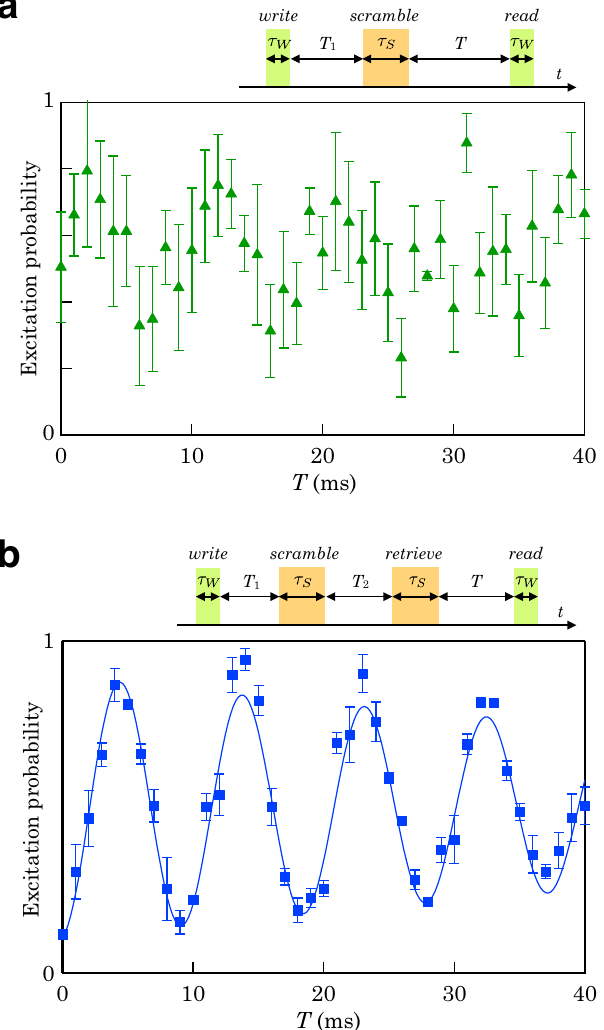
Figure 3. Experimentally obtained scrambled and retrieved Ramsey flops. ( a ) Encrypted state: excitation probability after the application of a scramble pulse in between the write and read pulses. The large error bars indicate the fluctuation of the excitation probability caused by the random phase modulation of the scramble pulse. ( b ) Decrypted state: excitation probability after the application of scramble and retrieve pulses in between the write and read pulses. After the application of a retrieve pulse, the Ramsey flop is restored. The line is a damped sinusoidal fit to the data, and the error bars reflect 1 σ statistical uncertainty.